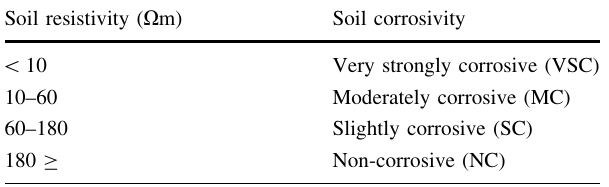
Table 3 Classification of soil resistivity in terms of corrosivity (Baeckmann and Schwenk 1975; Agunloye1984; Oladapo et al. 2004) Soil resistivity ( X